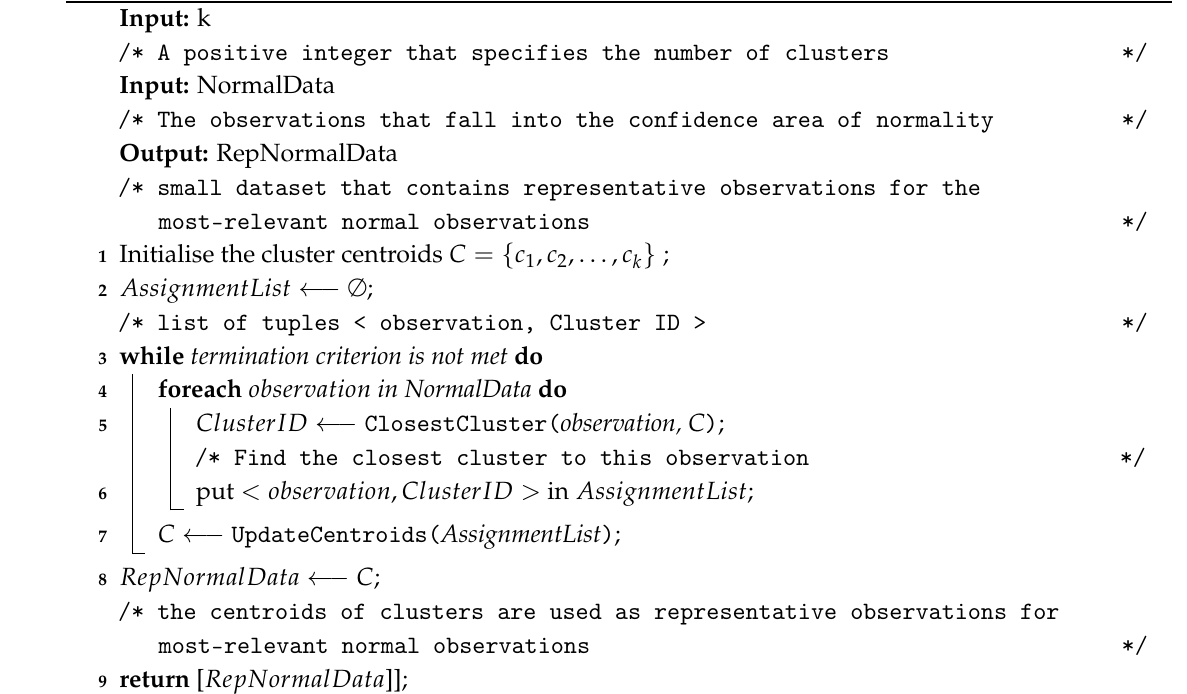
Algorithm 2: Learning a small, representative dataset of the most-relevant normal